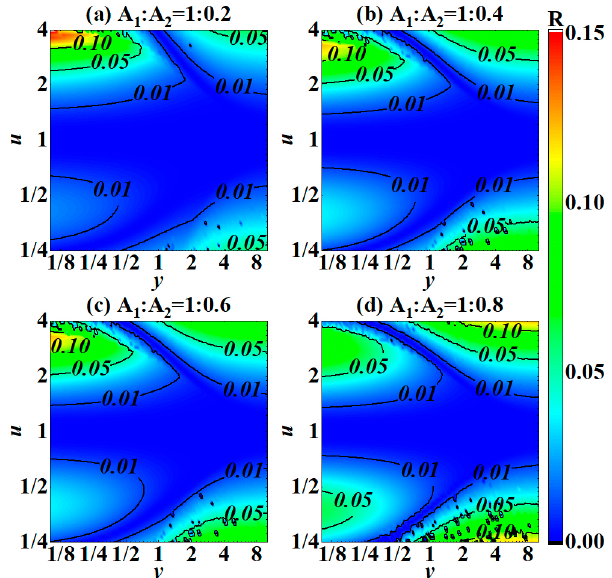
(cid:48) = y = x (cid:48) 2 , u 2 , and different 1 / x